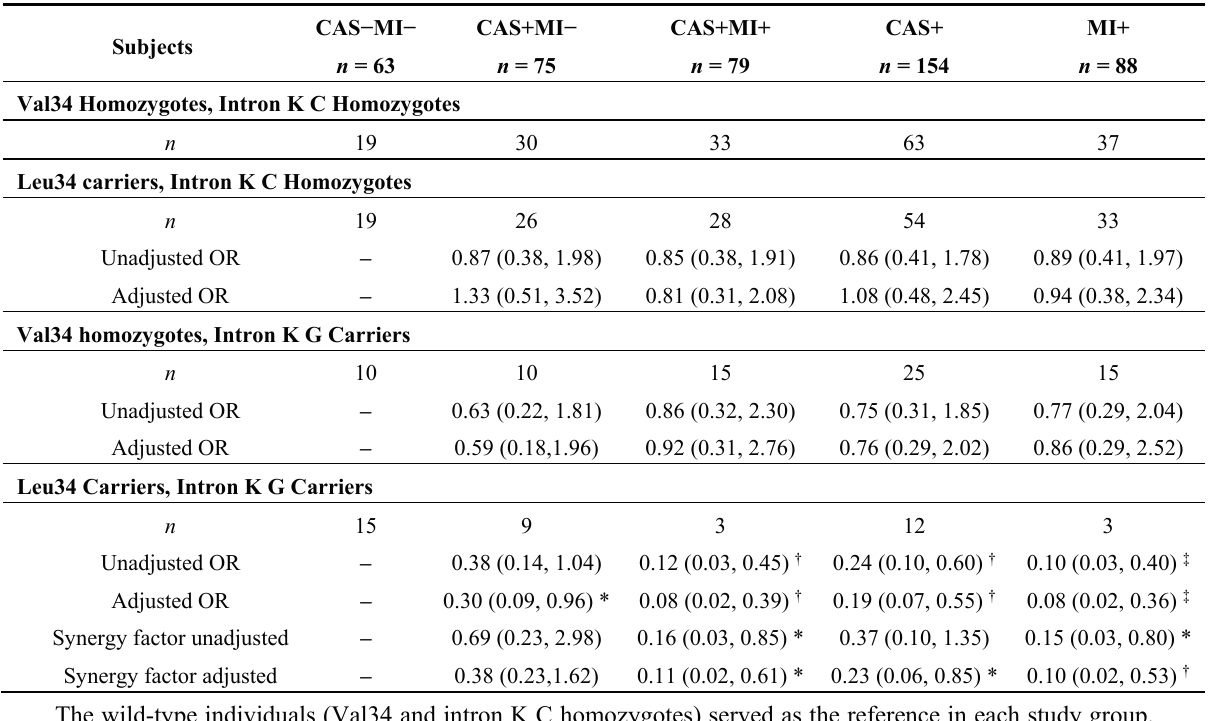
Table 4. Effect of combined FXIII-A Leu34 and FXIII-B intron K nt29756 G carriership on the risk of CAD in individuals with fibrinogen concentration in the upper